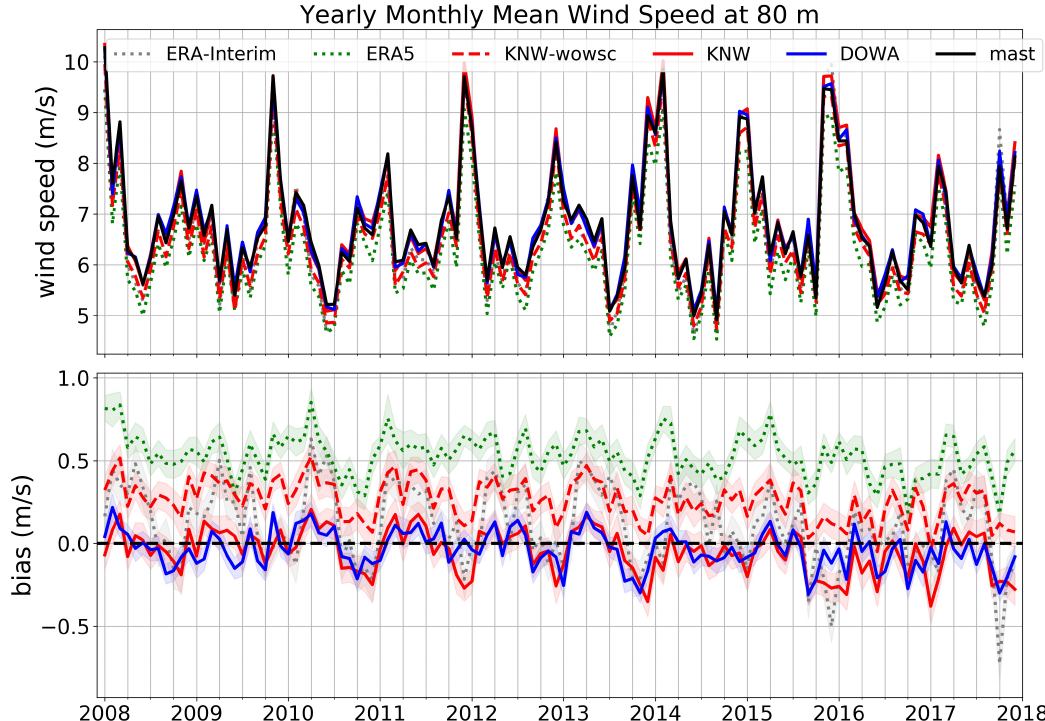
Figure 3. Yearly monthly mean wind speed at 80 m, showing mast measurements (black), DOWA (blue), KNW atlas (red), KNW atlas without wind shear correction (red, dashed), ERA5 (green, dotted) and ERA-Interim (gray, dotted). The upper panel shows the wind speed of both mast measurements and models, the lower panel the bias (measurement minus model) between the mast measurements and the models. Model variance is indicated by the shaded areas in the lower